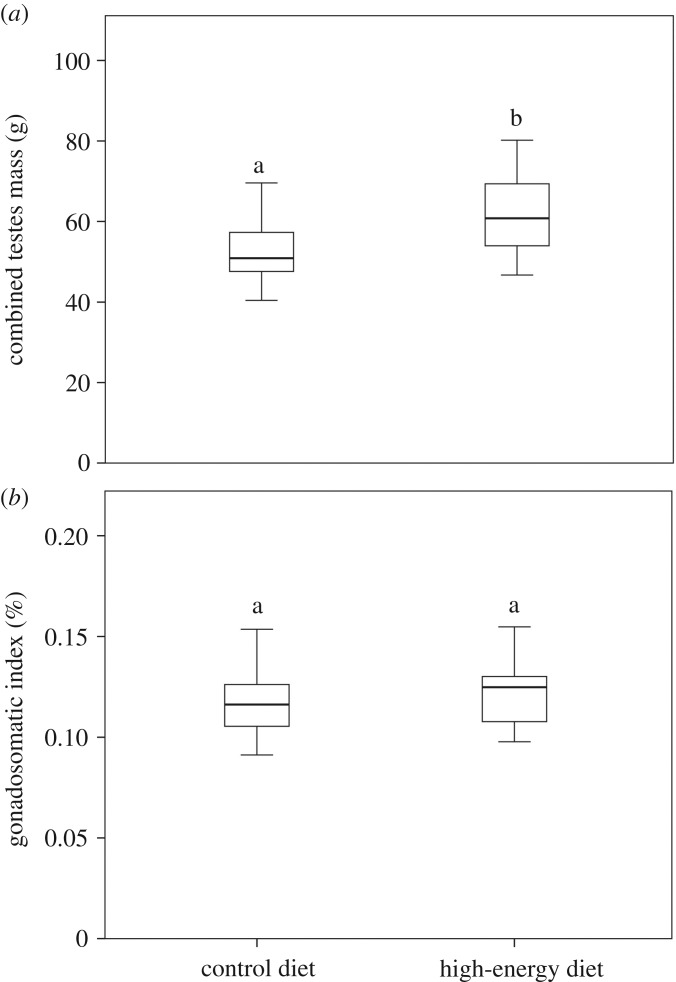
(a) Combined testes mass and (b) gonadosomatic index of fallow deer yearlings fed with pasture (control diet, N = 15) or pasture with barley grain supplementation (high-energy diet, N = 16). Different letters above the box plots indicate significant differences between groups (p < 0.05).